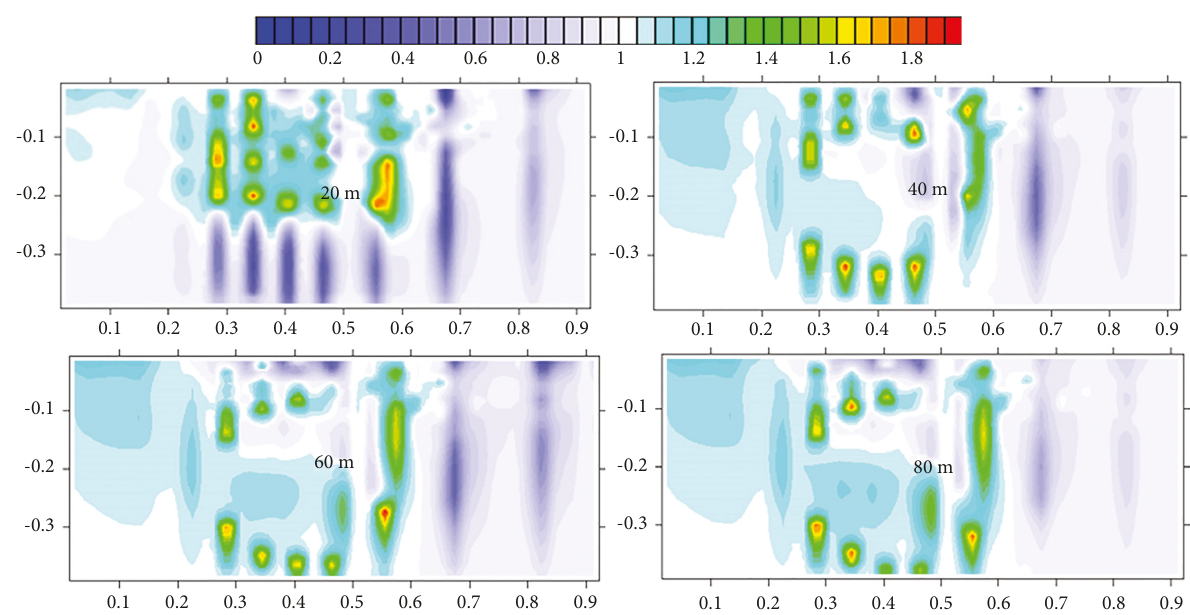
Figure 22: The resistivity section ratio chart in the x - z plane at 40cm above the coal seam ( y